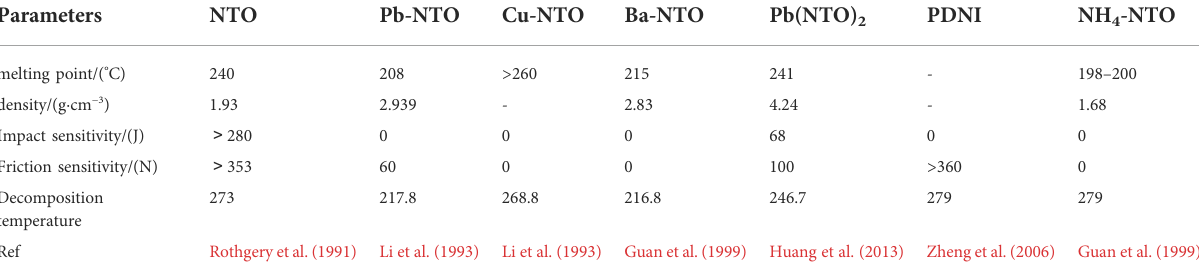
TABLE 1 The physicochemical properties of some NTO